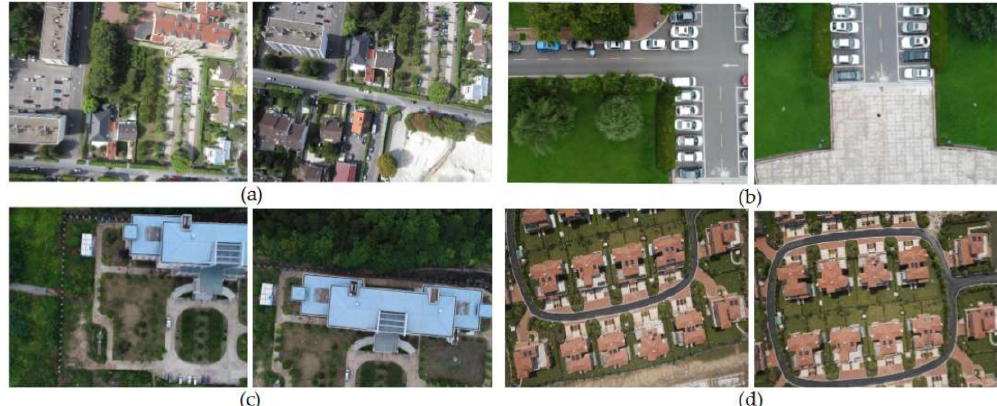
Figure 7. Four experimental UAV image pairs from four data sets: ( a ) The first image pair; ( b ) the second image pair; ( c ) the third image pair; ( d ) the fourth image pair.